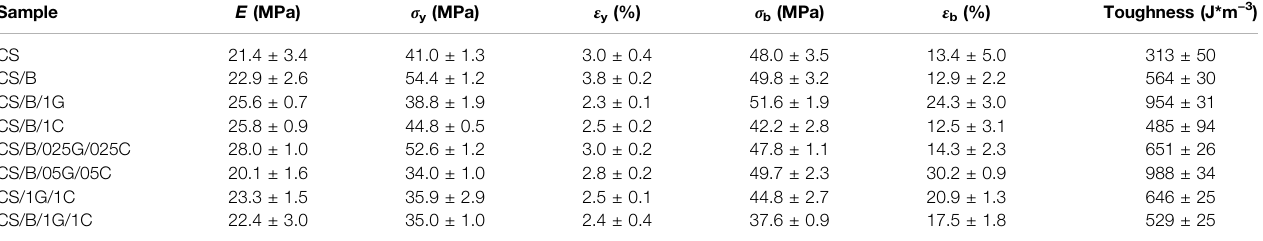
TABLE 4| Young ’ s modulus ( E ),stress ( σ y ) and strain ( ε y ) at the yield point, stress( σ b ) and strain ( ε b ) at break, and toughnessobtained from stress-strain curves of Figure 6 . Sample